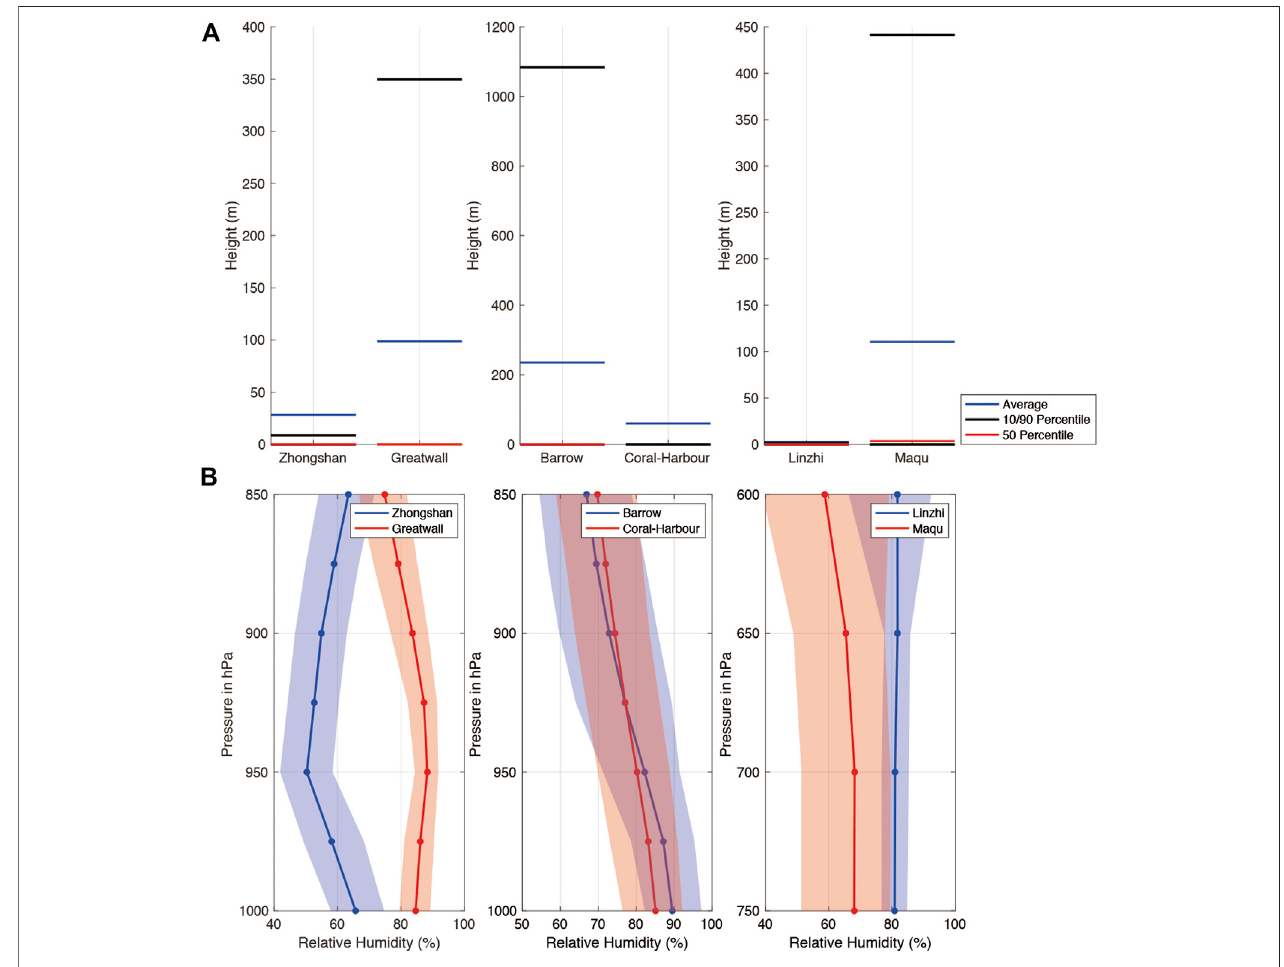
FIGURE 6 | (A) The average heights and 10/50/90 percentile freezing levels of the ERA5 reanalysis above each station during snowfall events and (B) the mean vertical relative humidity distribution of the ERA5 reanalysis at six stations (the shadow boundaries are the 10 and 90 percentiles of relative humidity).